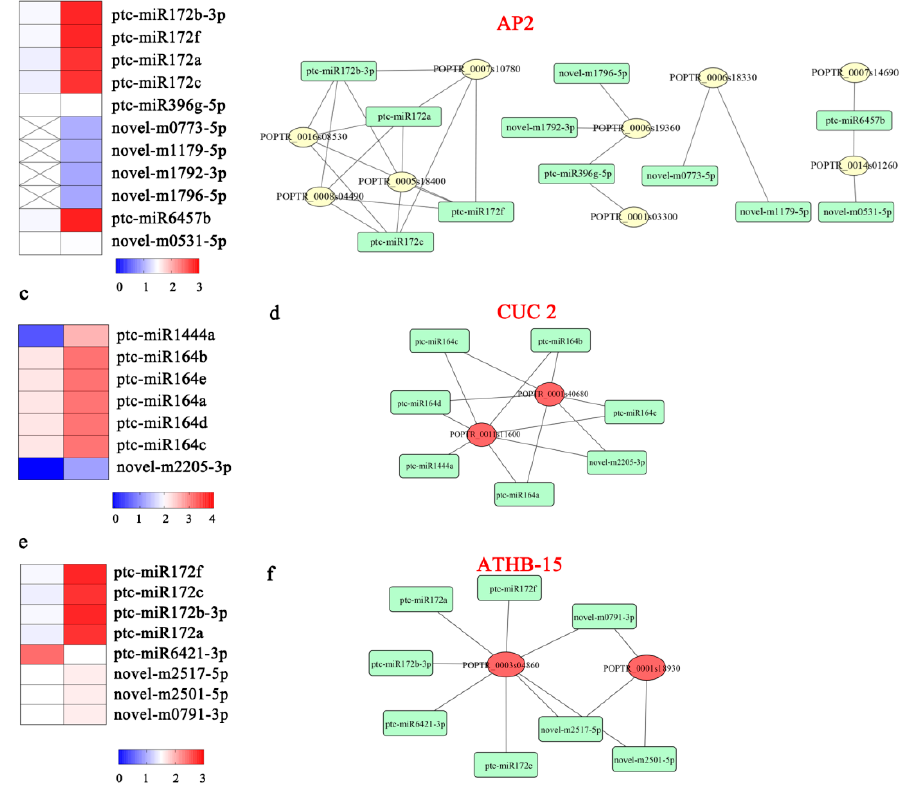
Figure 5. Heatmaps and networks of the differentially expressed miRNAs and their targets AP2 ( a , b ), CUC2 ( c , d ), and ATHB-15 ( e , f ). In the heatmaps, the coloured blocks represent the log 10 transcript per million (TPM) values of miRNAs in the shoot apical meristem (SAM) and leaf. Red indicates highly expressed miRNAs; blue indicates moderately expressed miRNAs; × indicates non-expressed